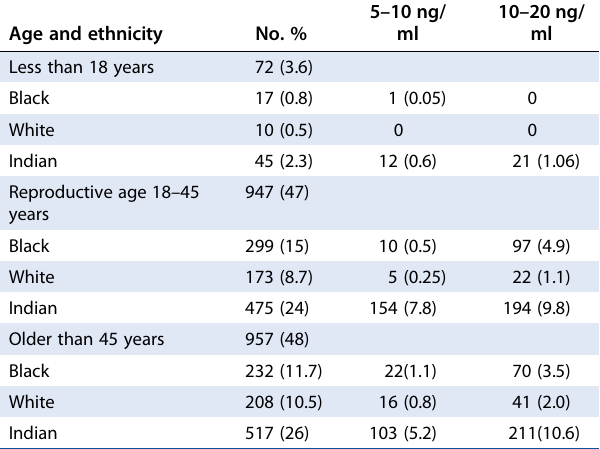
Table 2: Frequency of 25(OH)D deficiencies among the female population